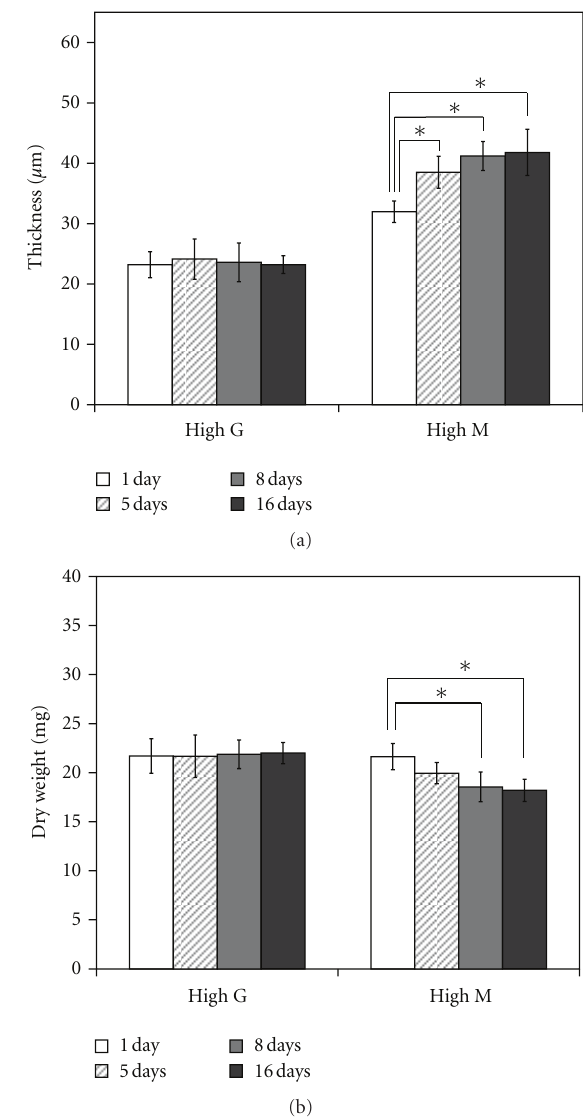
Figure 4: Alterations in Fe-alginate gel properties during culture. Changes in gel properties were determined by measurement of gel thickness (a) and dry weight (b). Error bars indicate standard deviation for n = 5. ∗ P < 0 .